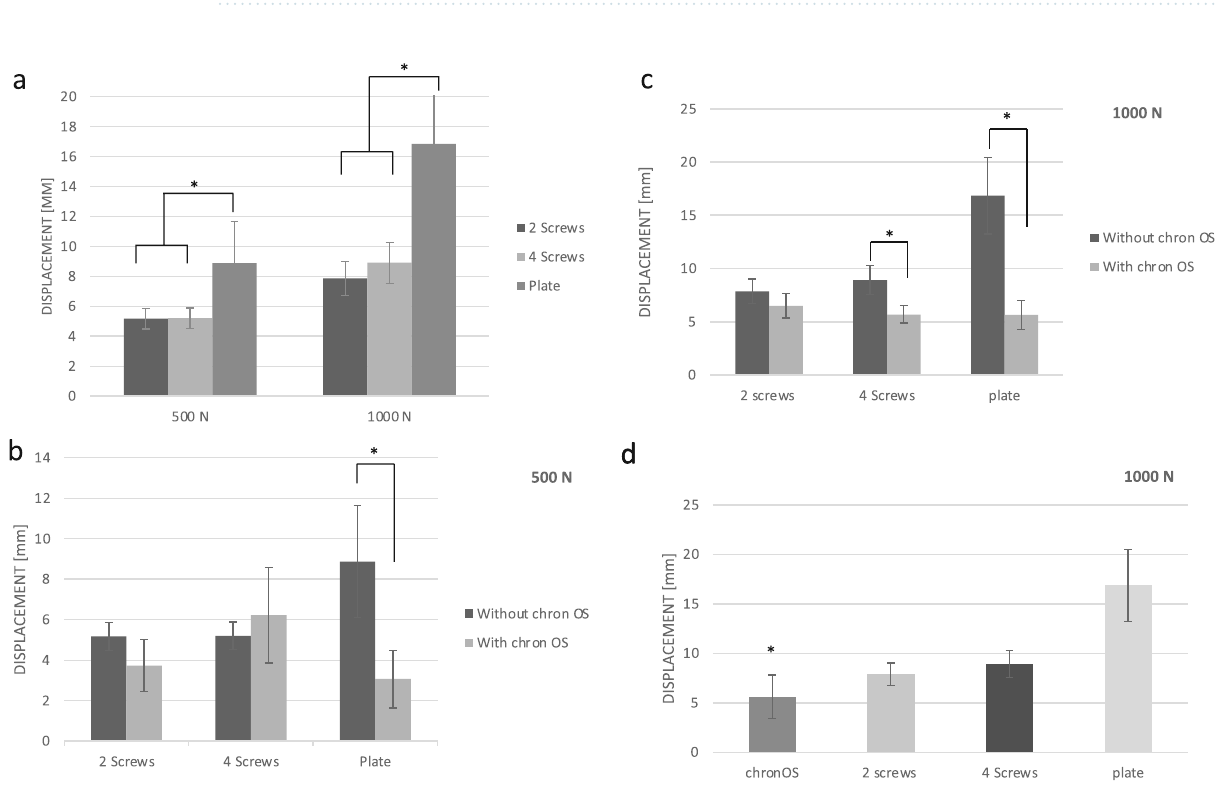
Table 2. The results of all parameters of interest are shown with the mean and standard deviation of every group.